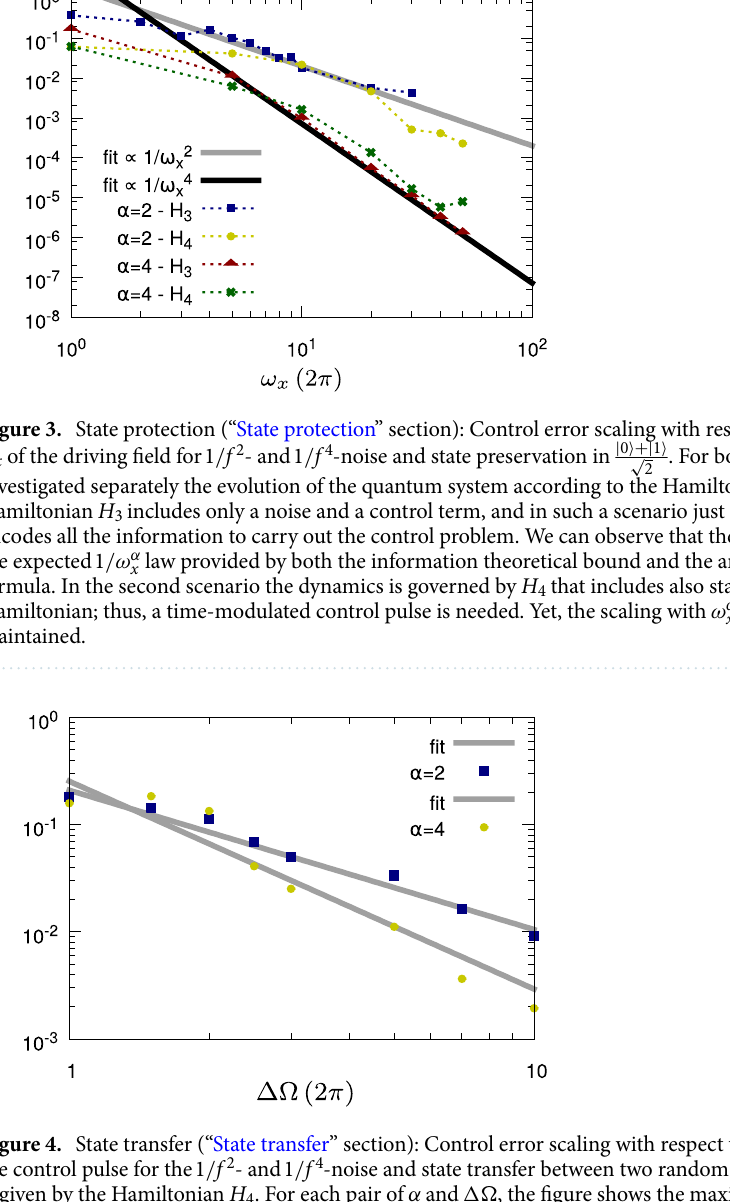
2, 4 we fit the scaling of the control error ε ∈ { } 1.3 and a 1.9 for α 2 and α 4 , = = = =